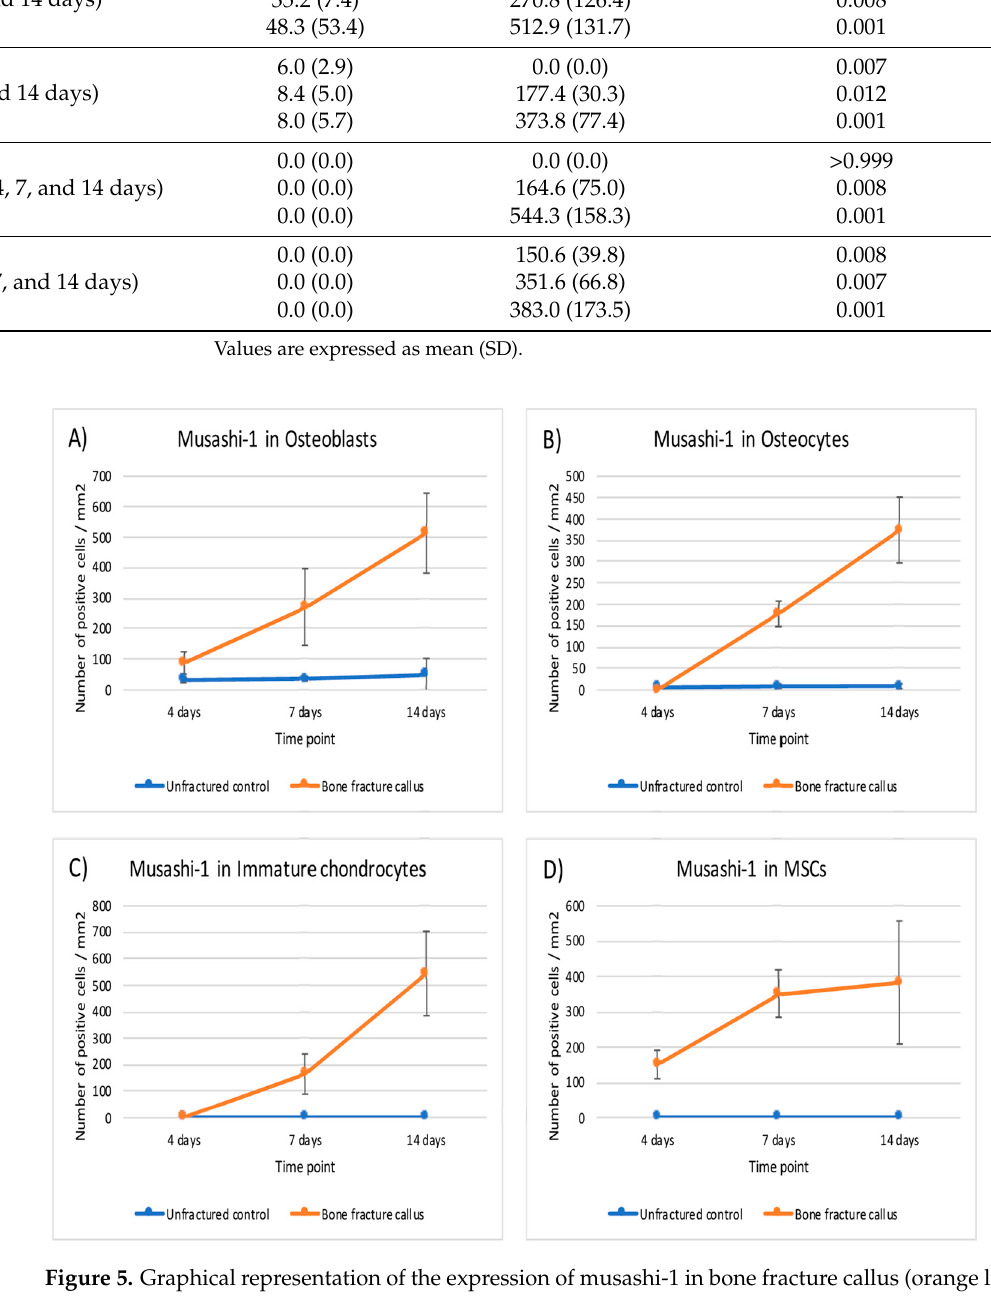
Table 1. Comparison between the expression of Musashi-1 in bone fracture callus and unfractured control areas. Expression of Musashi-1 ( Positive Cells/mm 2 ) Unfractured Control Bone Fracture Callus